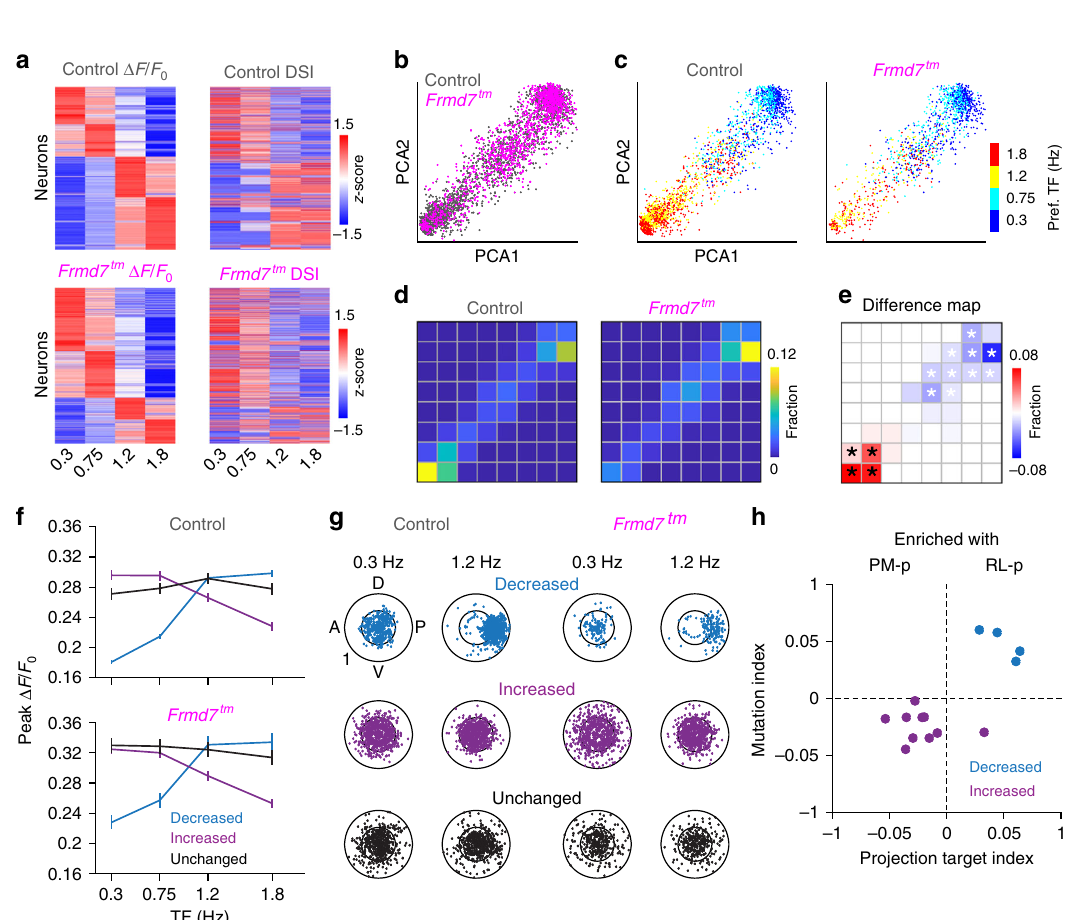
Fig. 4 V1 L2/3 neurons with distinct functional characteristics are sensitive to disruption of retinal horizontal direction selectivity. a Response matrix composed of TF-dependent response amplitudes and DSI for all pooled V1 L2/3 DS cells (target-unspeci fi c, PM-p, and RL-p) sorted by TF preference. b Two-dimensional (2D) visualization of the 1st and 2nd principal components for the response matrix shown in a . Each point represents one neuron. c TF preference of individual V1 neurons. d Fraction of neurons in 8 × 8 grids (gray lines) calculated from the PCA plot shown in b for control and Frmd7 tm mice. e Fraction difference map between control and Frmd7 tm mice. Black and white asterisks: signi fi cantly decreased and increased fractions in Frmd7 tm mice, respectively, P < 0.05, two-sided χ 2 test with Yates correction. f Peak response amplitude as a function of TF for three groups (decreased, increased, or unchanged in Frmd7 tm mice) in control (886, 845, and 591 DS cells, respectively) and Frmd7 tm mice (169, 825, and 381 DS cells, respectively). Error bars are SEM. g TF-dependent tuning characteristics of individual V1 neurons from the three groups in control and Frmd7 tm mice. Angular coordinate: preferred direction. Radial coordinate: DSI. Inner circle: DSI of 0.5. h Relationship between effect of Frmd7 tm mutation and enrichment in PM-p or RL-p neurons. x -axis: Index comparing axonal projection pattern for the individual grids in e that were decreased and increased in Frmd7 tm mice; groups with positive and negative index values are enriched in RL- and PM-projecting neurons, respectively. y -axis: Index comparing sensitivity to altered retinal direction selectivity for grids; grids with a positive and negative index value are decreased and increased in Frmd7 tm mice, respectively. Source data are provided as a Source Data fi